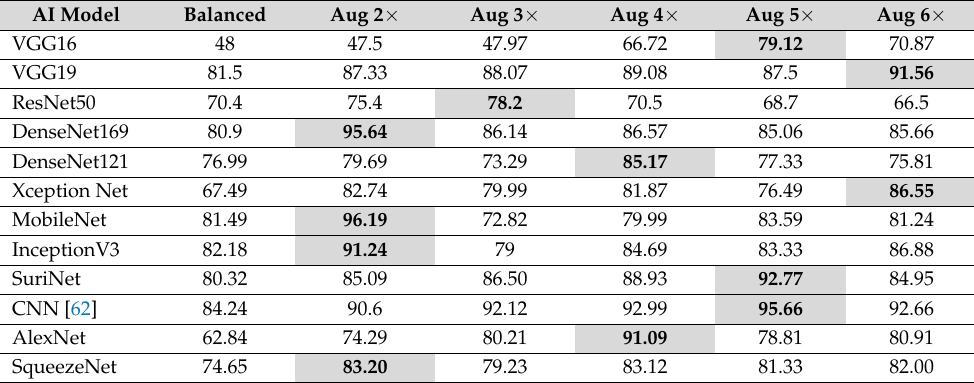
Table 2. Accuracies of 10 TL and 2 DL models for 6 augmentations. Bold represents the optimization point of each classifier.